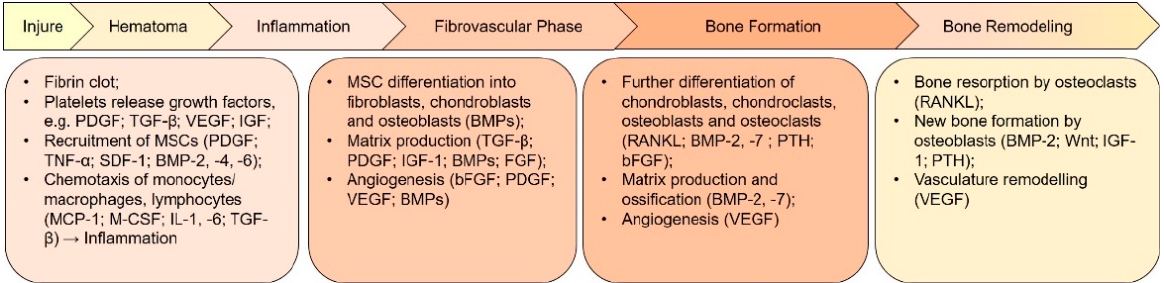
Figure 2. Key growth factors and events involved in the different phases of bone regeneration. The regeneration process can be divided into several phases that overlap each other. Each phase is regulated by many cytokines and growth factors secreted by different cell types. Revascularization and angiogenesis are ongoing through the inflammatory phase until the bone formation phase. BMP, bone morphogenetic protein; FGF, fibroblast growth factor; bFGF, basic FGF; IGF-1, insulin-like growth factor 1; MCP-1, monocyte chemoattractant protein 1; M-CSF, macrophage colony-stimulating factor; OPG, osteoprotegerin; PDGF, platelet-derived growth factor; PTH, parathyroid hormone; RANKL, receptor activator of nuclear factor κ B ligand; SDF-1, stromal cell-derived factor 1; TGF- β , transforming growth factor β ; TNF- α , tumor necrosis factor α ; VEGF, vascular endothelial growth